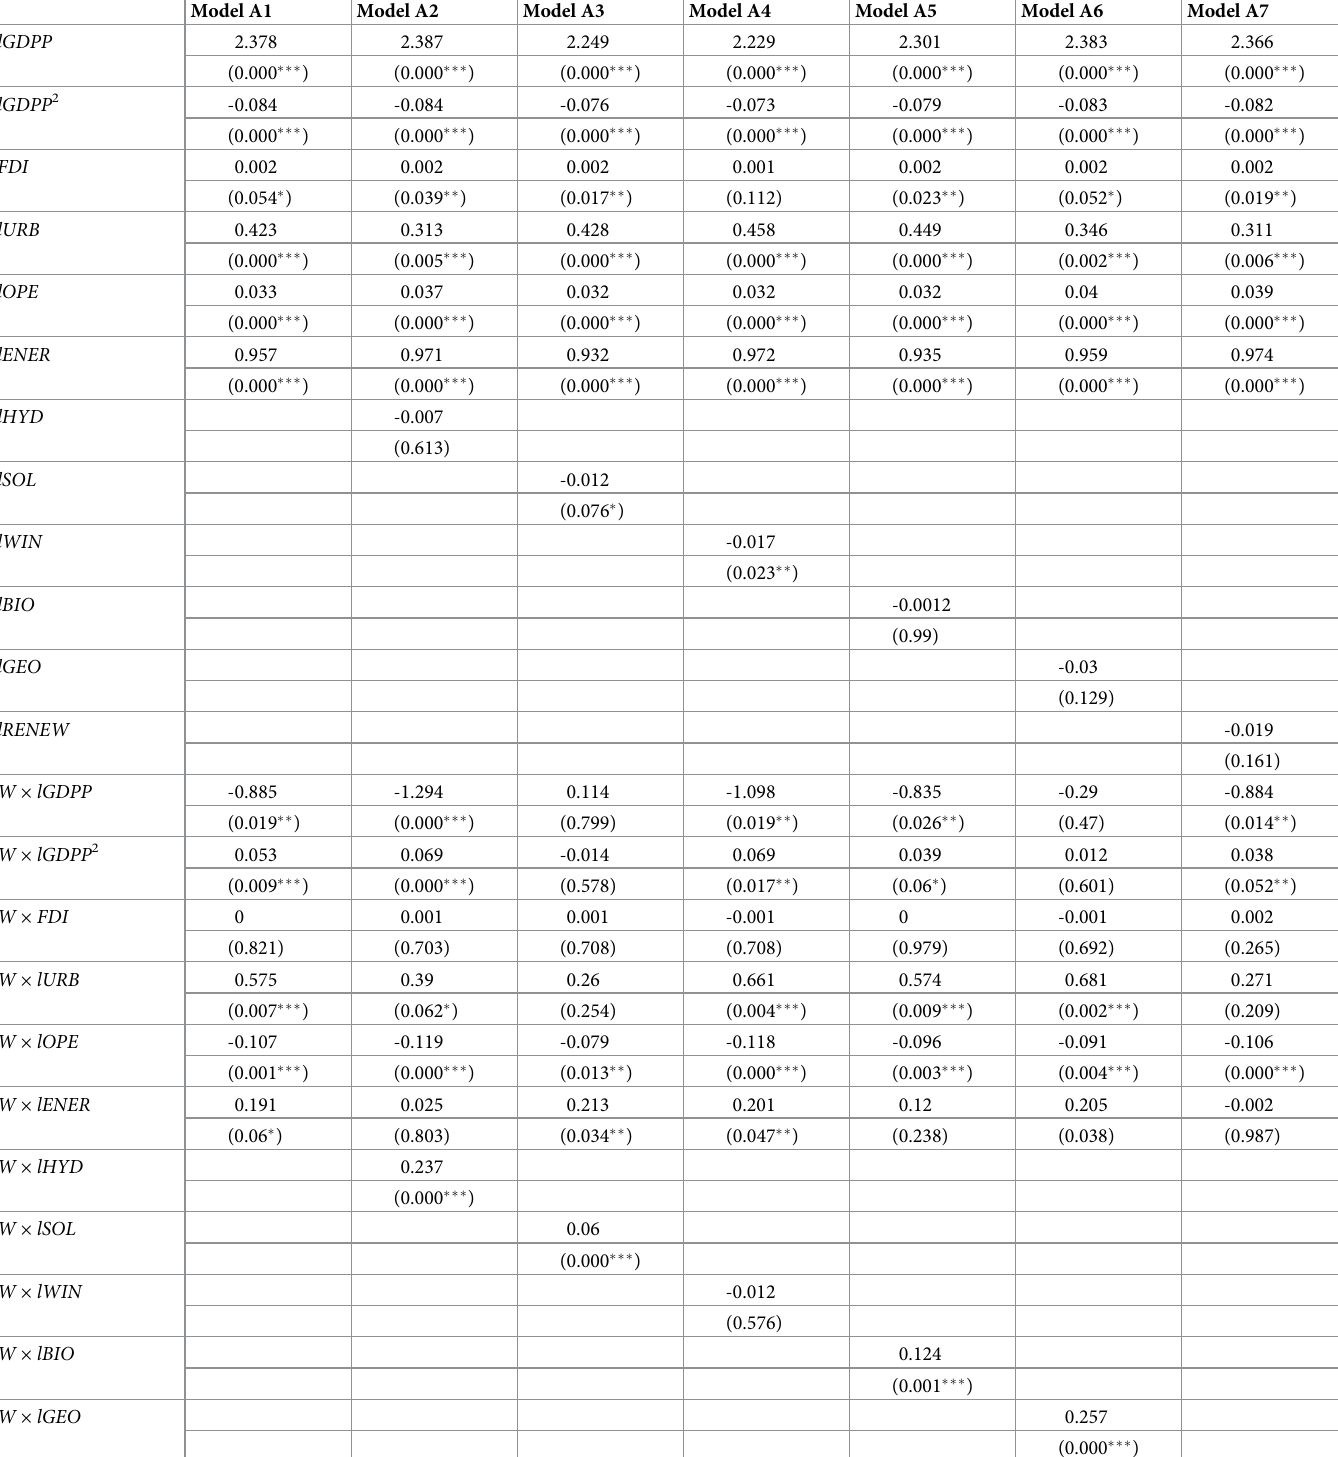
Table 5. The estimation results for the spatial fixed